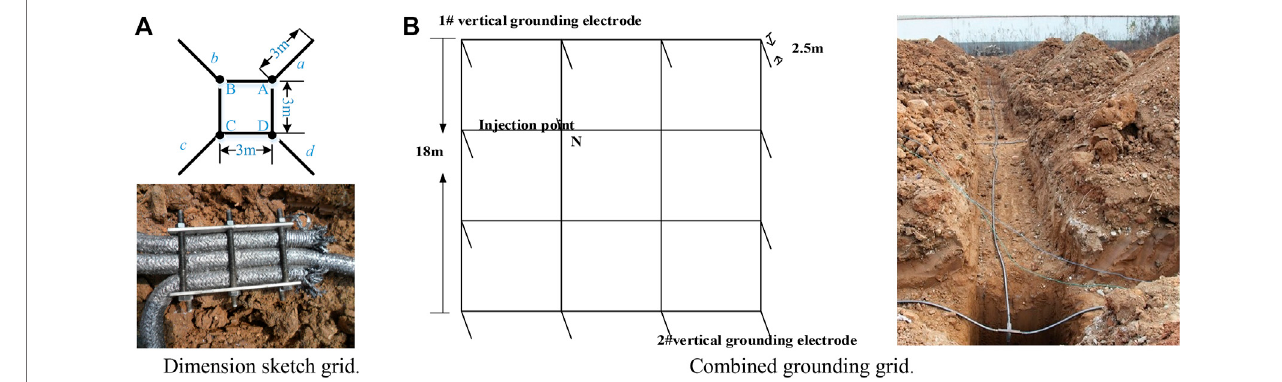
FIGURE 13 | Actual grounding simulation experiments.